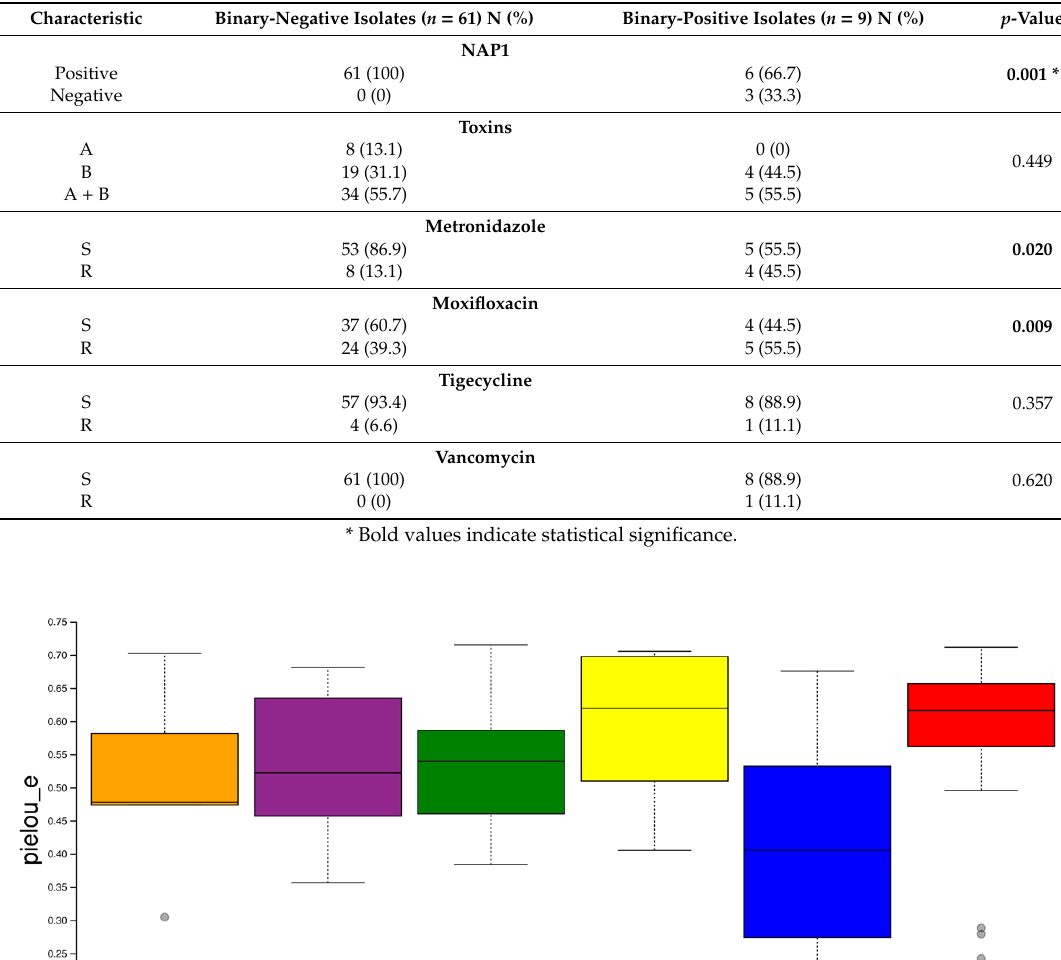
Table 5. Association between binary toxin gene presence and bacterial characteristics. Characteristic